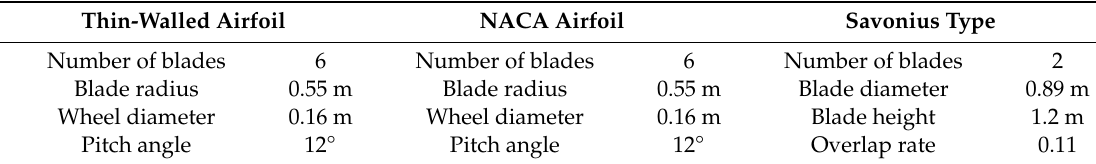
Table 6. Basic parameters of the